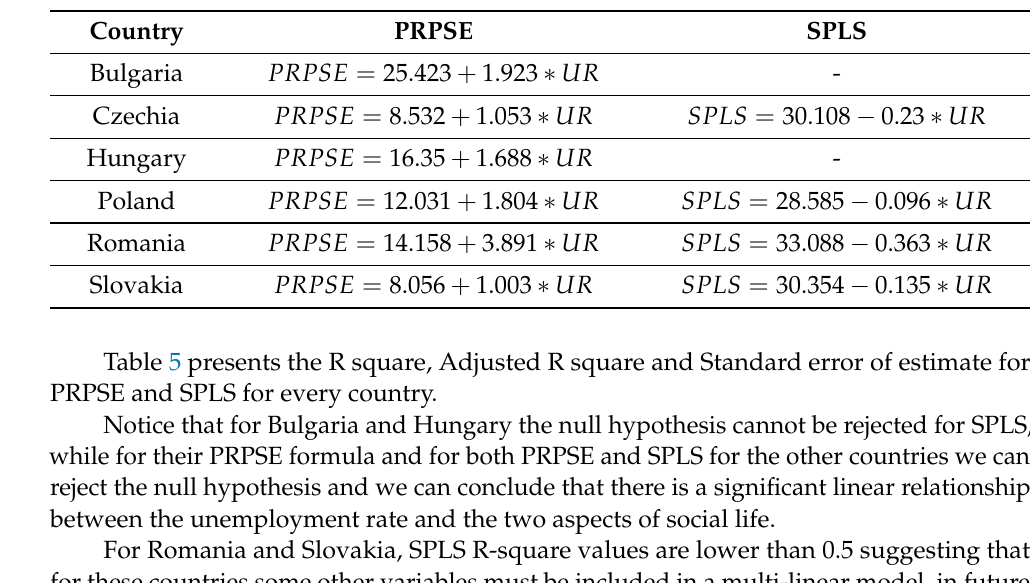
Table 4. Linear coefficients for the selected countries.